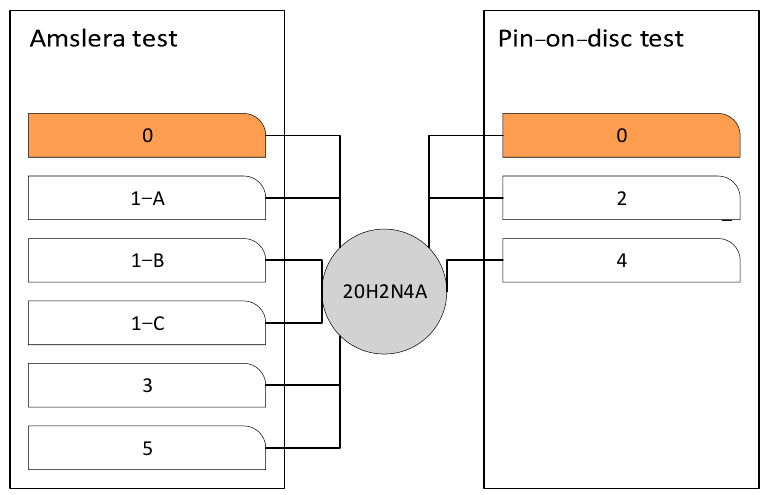
Figure 4. The tested friction pairs and the platforms used to assess the wear resistance .